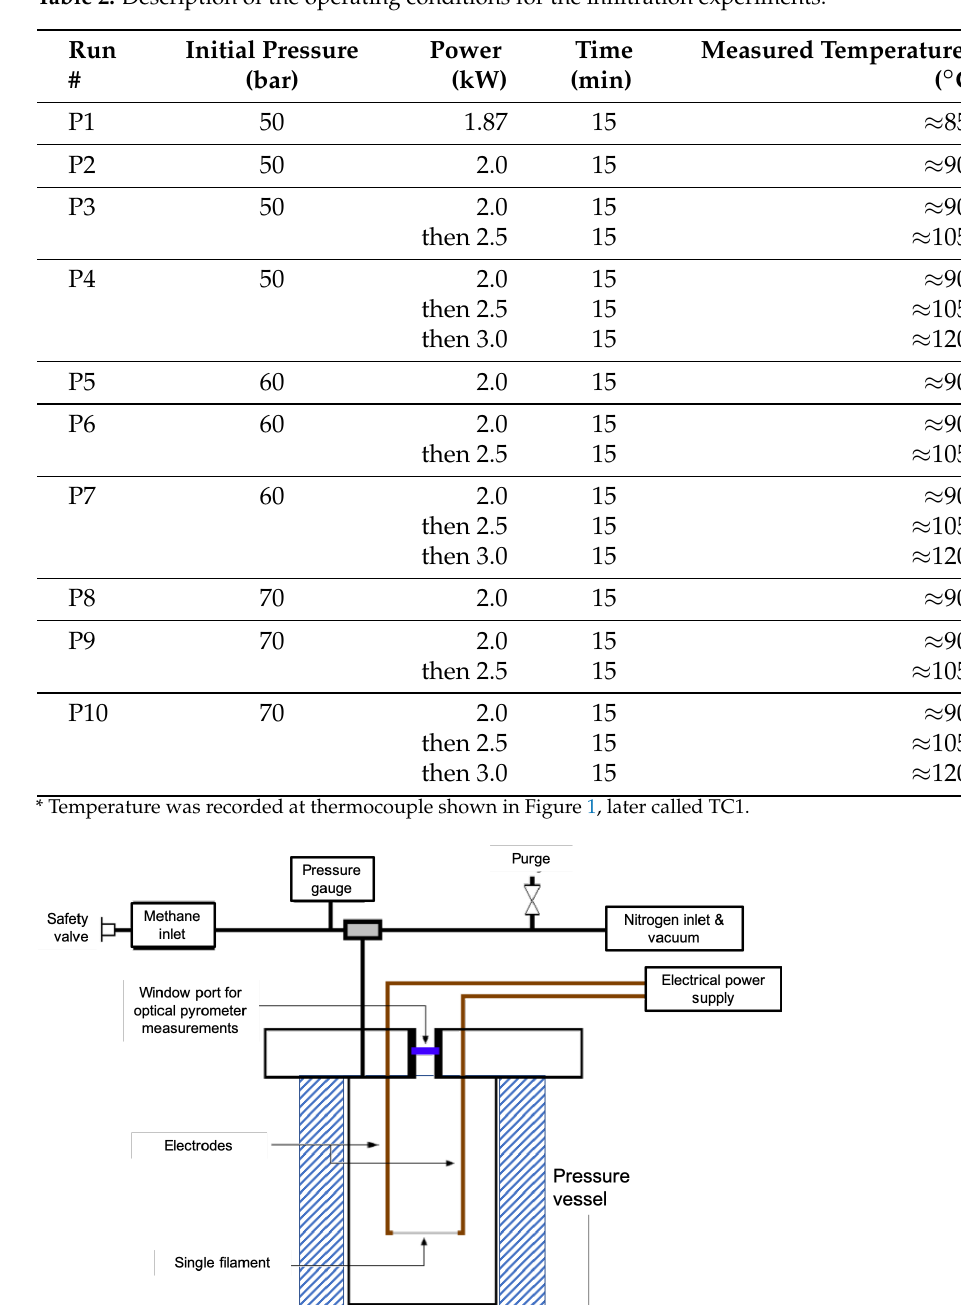
Table 2. Description of the operating conditions for the infiltration experiments.